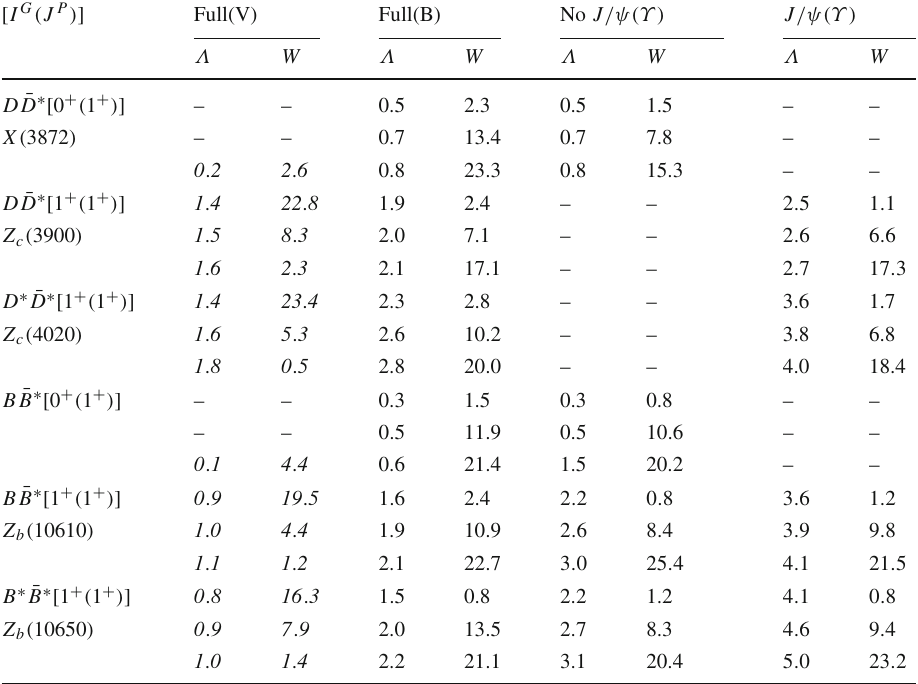
Table 4 The binding energy of some bound states with selected values of cutoff Λ . The results for virtual (V) and bound (B) states in full model and these without and only with J /ψ(Υ ) exchange are listed 2 − 3 rd , 4 − 5 th , 6 − 7 th , 8 − 9 th columns, respectively. Other notations are the same as in Table